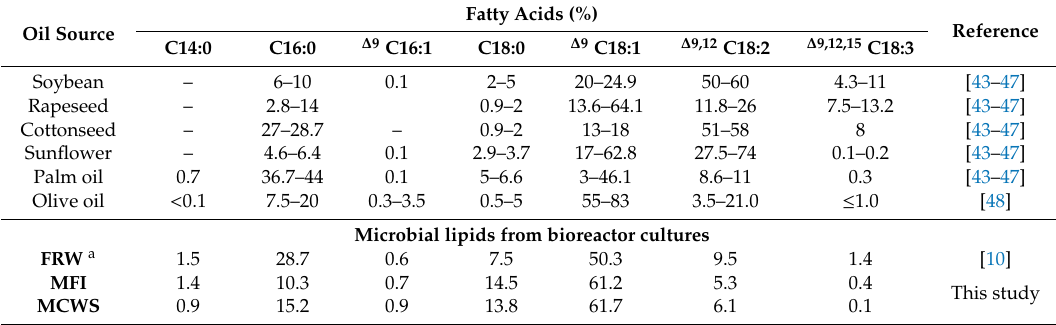
Table 4. Fatty acid composition of plant-derived oils compared with the composition of the microbial lipids produced during fed-batch bioreactor cultures of R. toruloides using the hydrolysates from mixed food for infants (MFI) and mixed confectionery waste streams